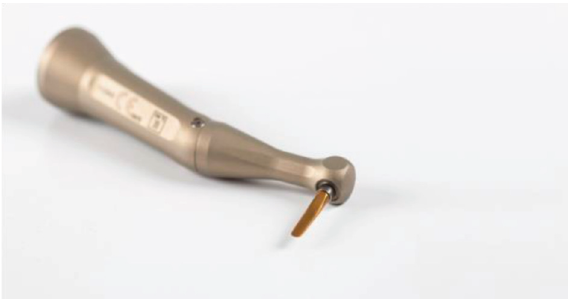
Figure 1: Luxator